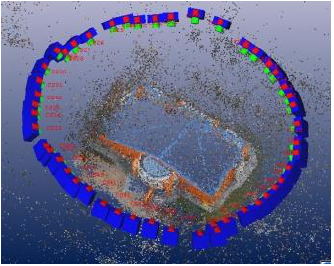
Figure 6. The camera positions and orientations and the dense point cloud